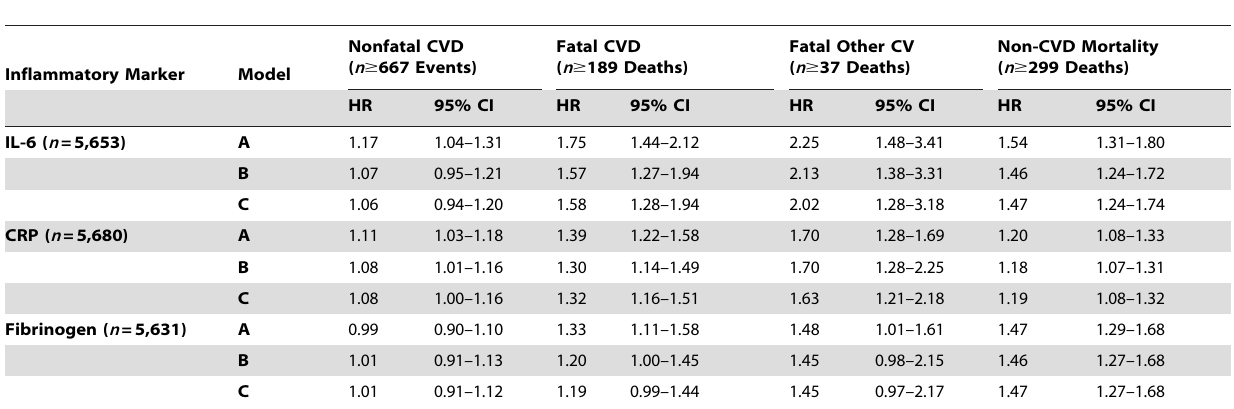
Table 3. Associations of IL-6, CRP, and fibrinogen with risk (HR for 1-unit increase in log IL-6, log CRP, or fibrinogen) of experiencing one of the four categories of